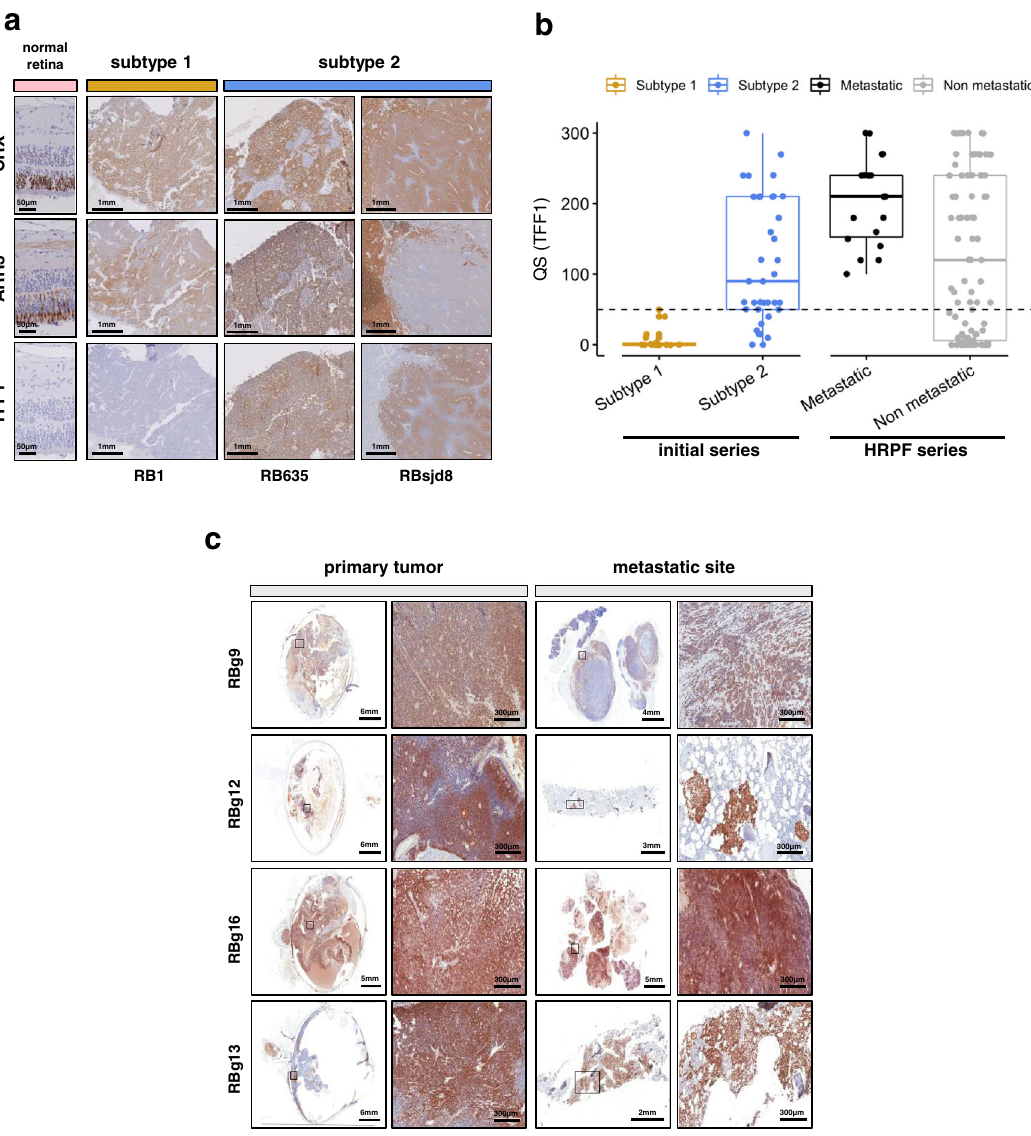
Fig. 6 Subtype 2 tumors are associated with a higher risk of metastasis. a Immunostaining of CRX, ARR3, and TFF1 in normal retina and